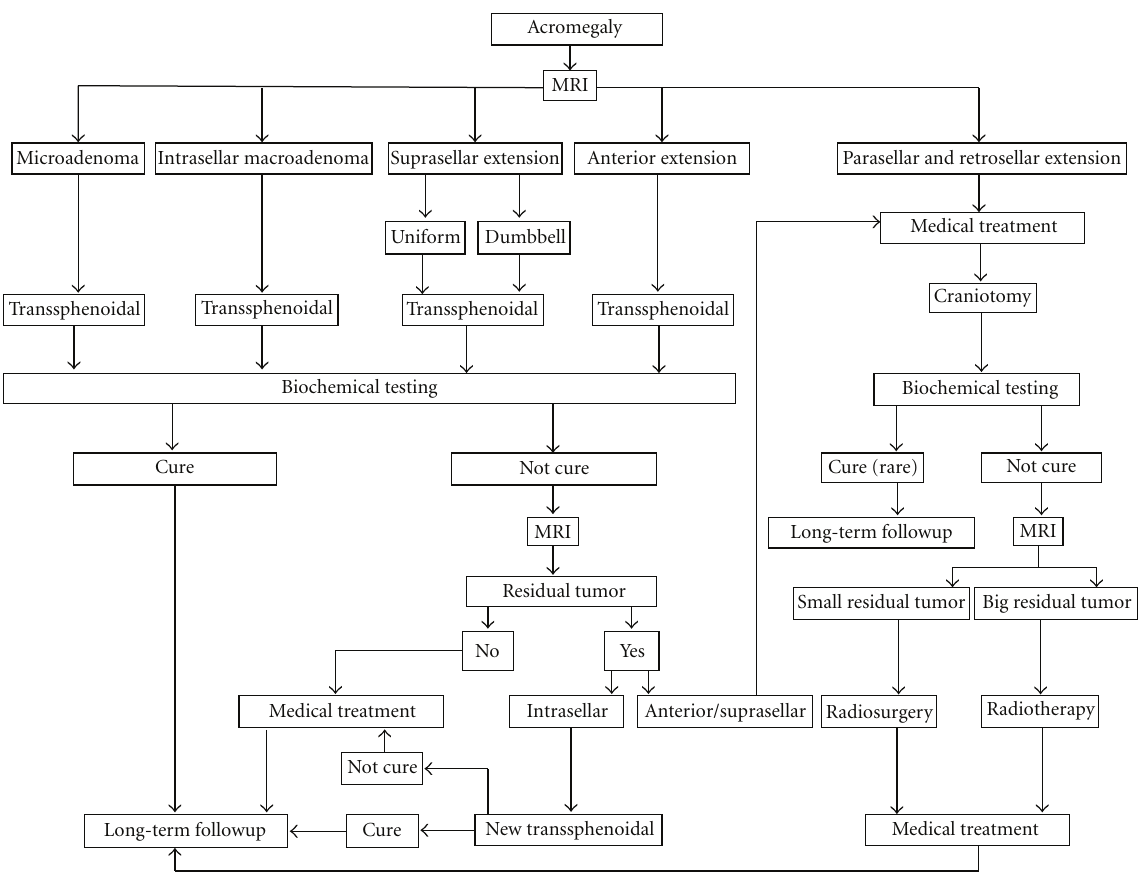
Figure 11: Summary of the most important therapeutic options used today for